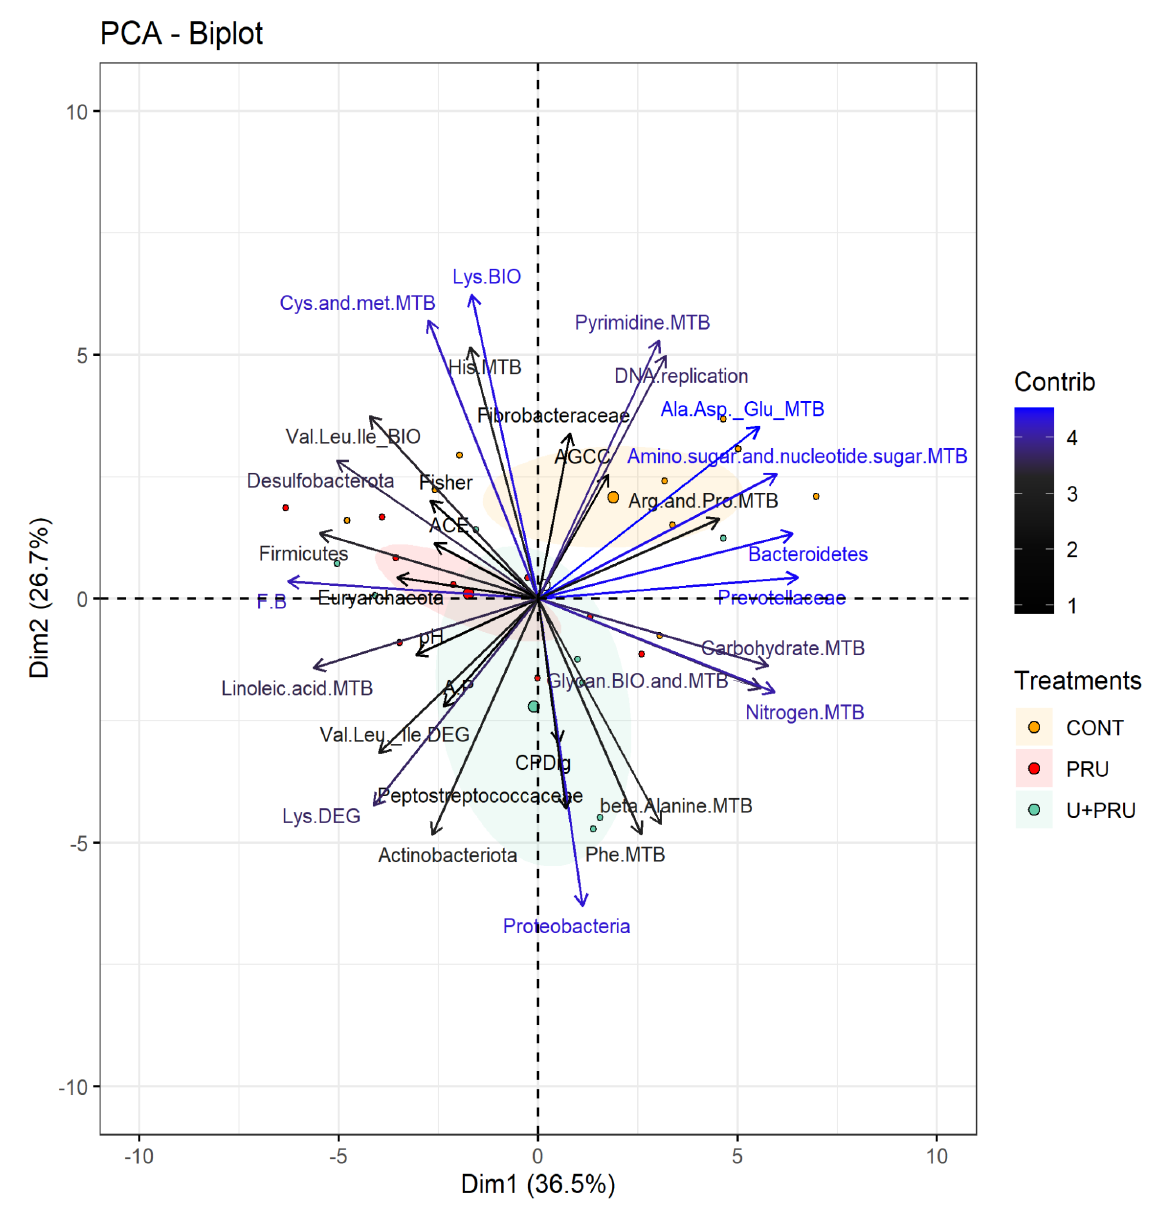
Figure 2. Principal component analysis (PCA) from rumen microbiota associated with KEGG pathways, fermentation parameters, and nutrient digestibility in Nellore steers as a function of the use of post-ruminal urea and conventional urea during the dry season. Ellipses represent the Eu- clidean distance among treatments. Blue letters represent variables with a higher contribution.